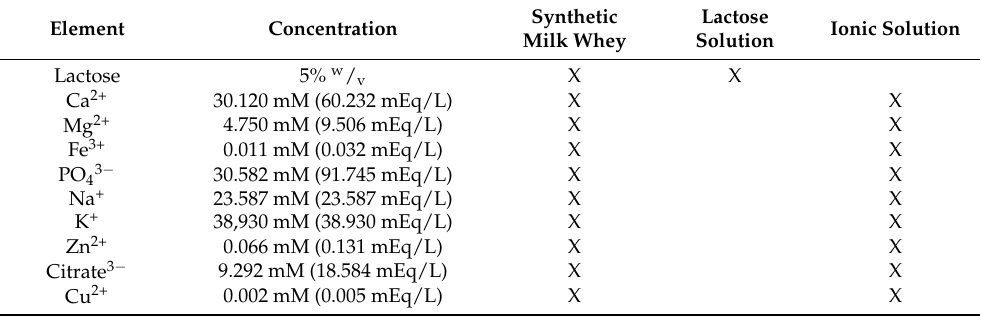
Table 2. Solutions employed to study the effect of soluble milk constituents on the aggregation of the NAS.